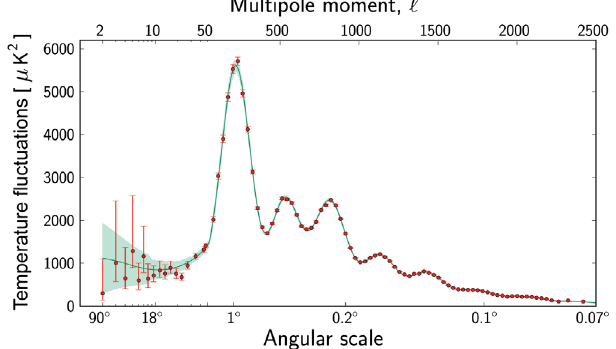
FIG. 34. Power spectrum of temperature fluctuations in the cosmic microwave backgrounds. Image credit: ESA and the Planck